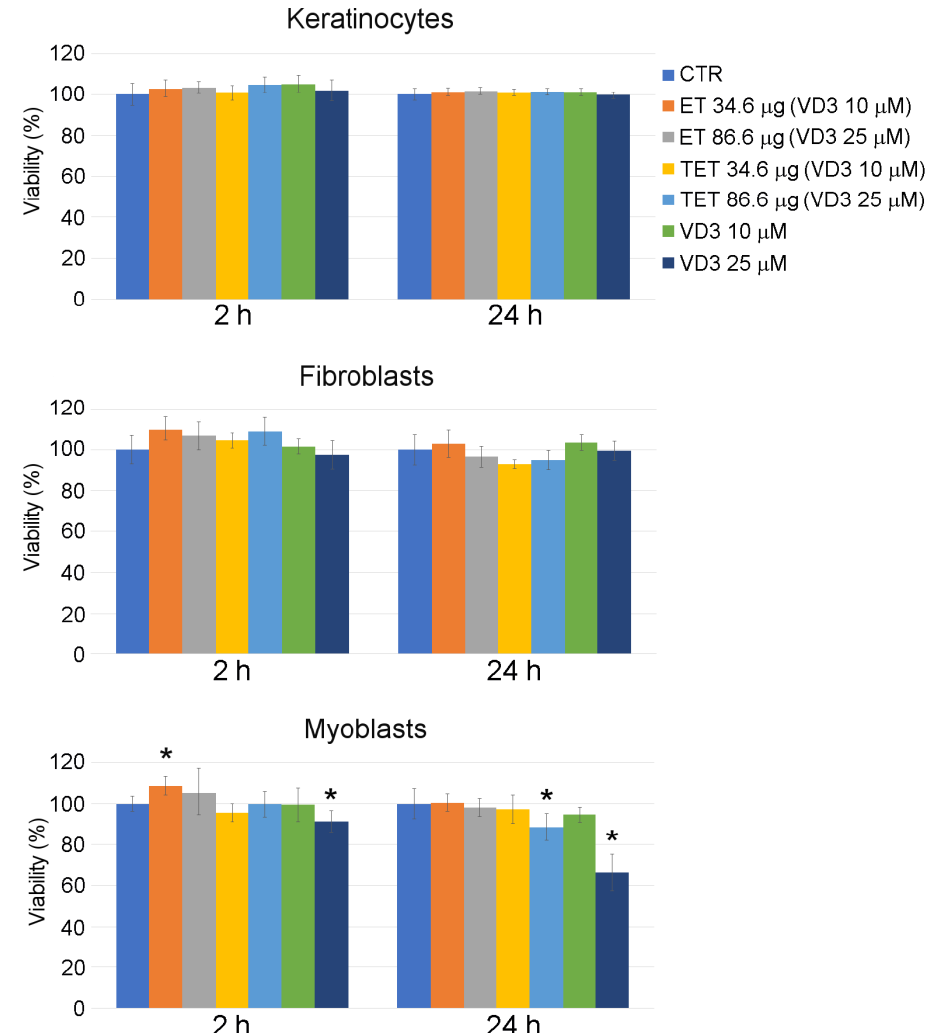
Figure 3. Effect of ET-VD3, TET-VD3 and VD3 on cell viability of cultured keratinocytes, fibroblasts and myoblasts, as measured by MTT assay. Histograms show the mean percentage value ± s.d. of cell viability after 2 h and 24 h of incubation with nanocarriers or VD3 as in at different concentrations. * p < 0.05.